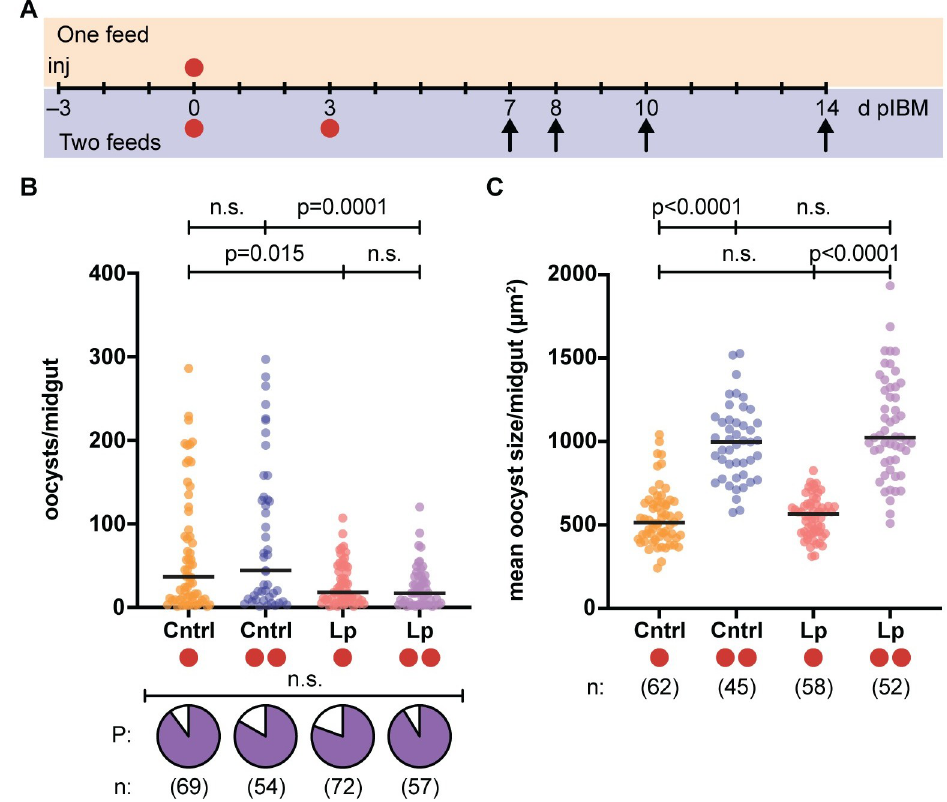
Fig 1. A second blood meal increases oocyst size in a Lp-independent manner. (A) ds GFP (Cntrl)- and ds Lp - injected females were infected with P . falciparum 3 days post injection (inj) and then either provided a second uninfected blood meal 3 days post infectious blood meal (d pIBM) (two red circles) or maintained on sugar (one red circle). Infection outcomes in all groups were determined at 7–14 d pIBM (arrows). (B) Oocyst prevalence (P, pie charts) ( χ 2 test: χ 2 = 4.3, d.f. = 3, n.s.) and intensity (Linear mixed model; FDR-corrected post-hoc Student’s t tests shown for all models) are not affected by a second blood meal at 3 d pIBM (#BF: n.s.), but intensity is lower in Lp- depleted groups (ds RNA : p < 0.0001). (C) Oocyst size at 7 d pIBM is significantly increased in females fed twice in both injection groups (Linear mixed model; #BF: p < 0.0001; ds RNA : n.s.). Horizontal bars indicate median values. n = numbers of mosquitoes analyzed from 3 different experiments. n.s. = not statistically significant. See S1–S4 Tables for details of statistical models. Table ) or intensity of infection ( Fig 1B , prevalence shown in pie charts), we observed a strik- ing increase in oocyst area in females that had been blood fed a second time, measured by aver- aging the cross-sectional area of up to 50 mercurochrome-stained oocysts in each midgut ( Fig 1C ). Median oocyst size was 94% larger in these females (model: #BF: p < 0.0001), suggesting increased parasite growth rates following an additional blood meal. However, increased oocyst size was not mediated by Lp-transported lipids, as after a second blood meal oocysts in Lp - silenced females showed an increase in size comparable to those in ds GFP females (model: ds RNA : n.s.; Fig 1C ). Lp silencing did reduce oocyst numbers, but without affecting preva- lence, as previously observed after a single blood meal (model: ds RNA : p < 0.0001; Fig 1B ) [17,27]. We next performed immunofluorescence microscopy to assess the developmental stage of these oocysts using a DNA stain and an antibody recognizing the P . falciparum circumsporo- zoite surface protein (CSP), which is expressed during late oocyst development and on sporo- zoites [28]. At 8 d pIBM, while oocysts developing in females fed once had DNA but no